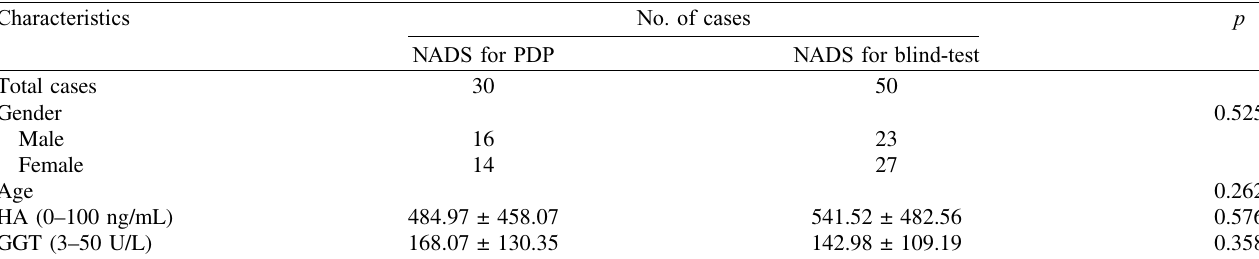
Table 3. Comparison of newly developed advanced schistosomiasis (NDAS) patients between the training group and the veri fi cation group. Characteristics